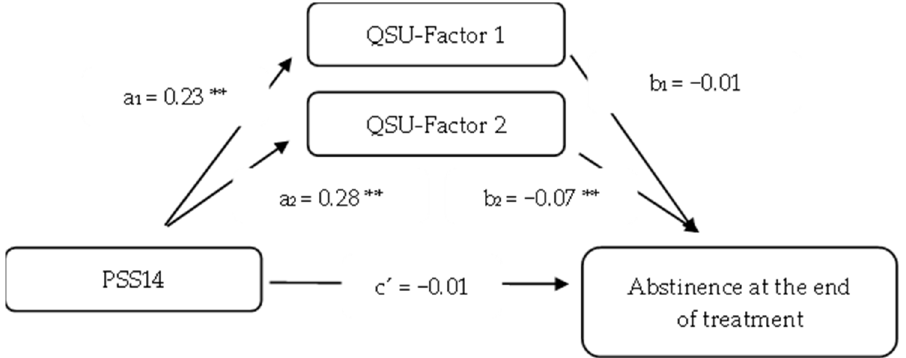
Figure 2. Multiple mediation model with QSU-Factors 1 and 2 as mediators. ** p < 0.01.